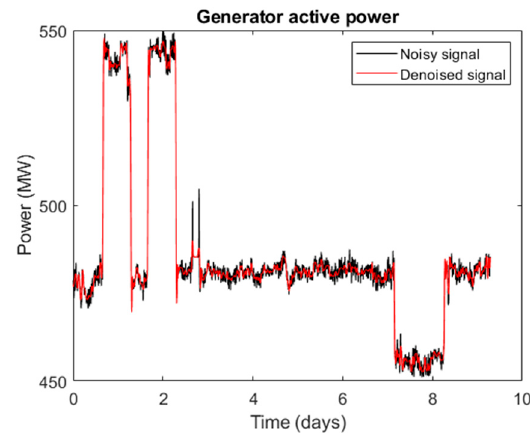
Figure 14. Wavelet denoising of the noisy data.